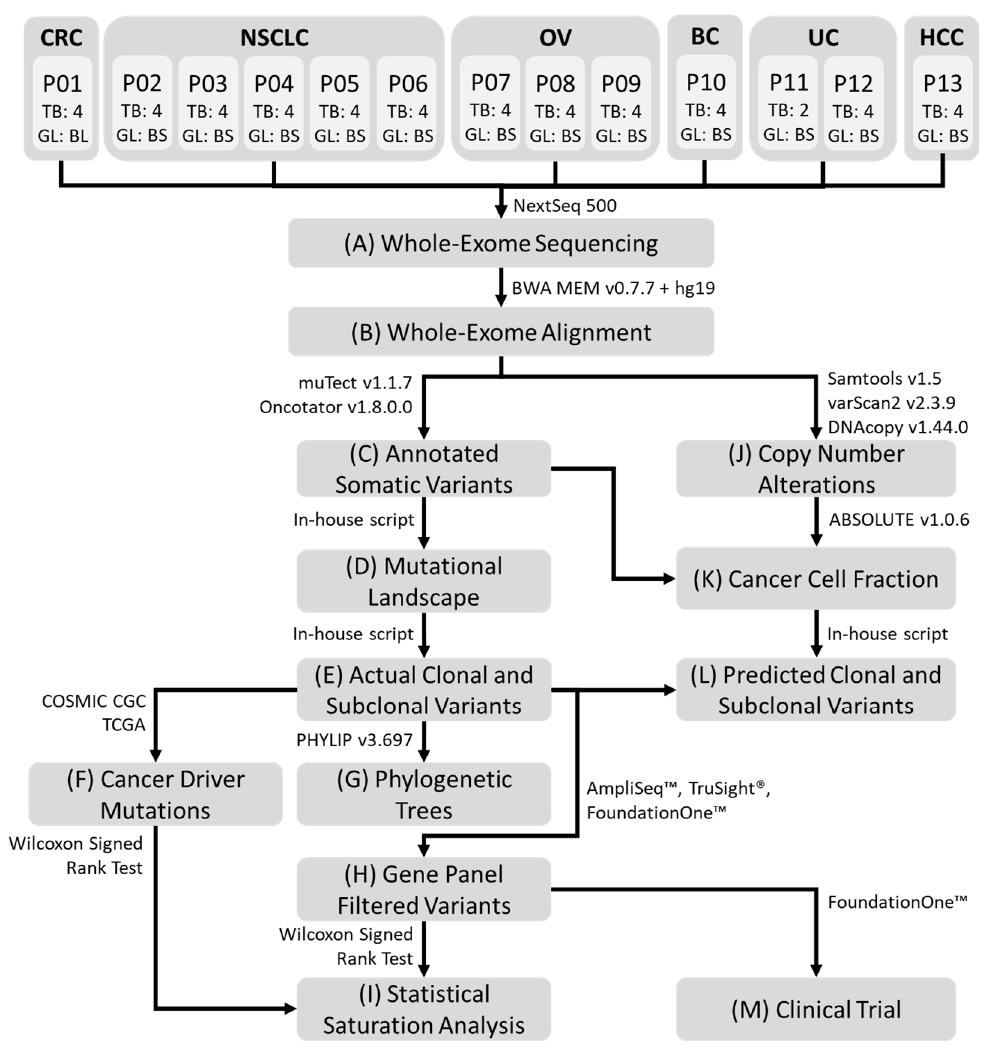
Figure 1. Representative workflow of the processing pipeline. ( A ) Whole-exome sequencing was performed on all germline and MRTB samples obtained from each patient. Bioinformatics analysis was subsequently performed: ( B ) alignment of sequence reads; ( C ) somatic variant calling and variant annotation; ( D ) generation of non-synonymous somatic mutational landscape across all patients; ( E ) identification of truncal and branch variants present in each patient; ( F ) curation of statistically significant somatic cancer driver mutations; ( G ) construction of phylogenetic trees from non-synonymous somatic variants; ( H ) filtering of genetic variants using AmpliSeq ™ , TruSight ® and FoundationOne ™ cancer gene panels; ( I ) statistical saturation analysis to determine the minimum number of MRTB samples needed (to alleviate challenges associated with ITH) in relation to the gene panel used; ( J ) copy number alterations analysis; ( K ) estimation of cancer cell fraction (CCF); ( L ) prediction of putative truncal variants using two different threshold metrics, namely variant allele frequency and CCF; ( M ) informed targeted therapies were performed based on patients’ mutational profile that reflects genes from the AmpliSeq ™ cancer gene panel. MRTB: multi- region tumor biopsy; ITH: intratumor heterogeneity; TB: the number of MRTB samples resected from the patient; GL: the type of germline sample; BL: whole blood sample; BS: buccal swab sample. CRC: Colorectal cancer; NSCLC: Non-small cell lung cancer; OV: Ovarian Cancer; BC: Breast cancer; UC: Uterine Cancer;